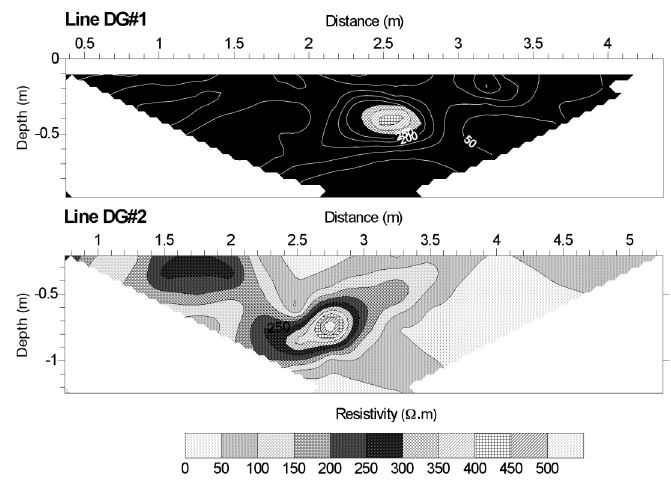
Fig. 2. Apparent resistivity raw data from dipole-dipole